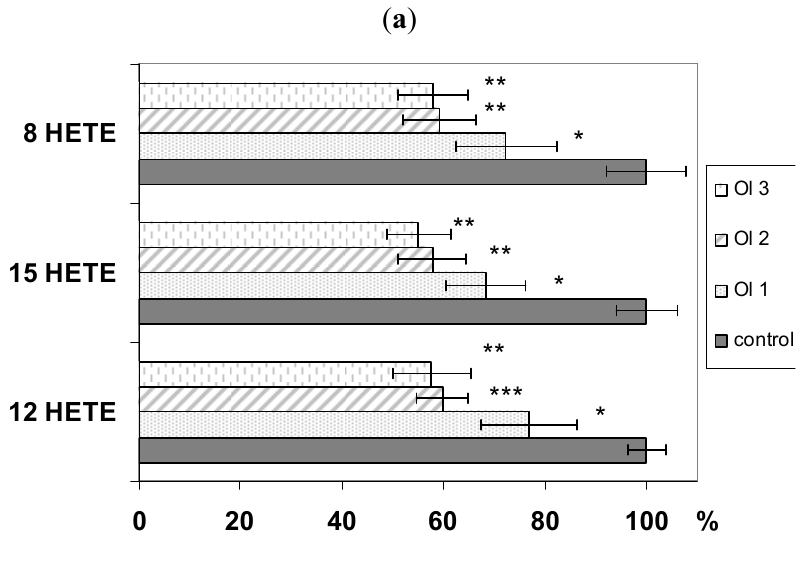
Figure 2. ( a ) Inhibitory activity of different concentrations of oleuropein on LOX; ( b ) Inhibitory activity of different concentrations of echinacoside on LOX; ( c ) Inhibitory activity of different concentrations of Ligustrum vulgare infusion on LOX. Each value is average ± SD of three separate experiments, * pt < 0.05, ** pt < 0.01, *** pt < 0.001 (statistical significance for individual samples compared to those of the